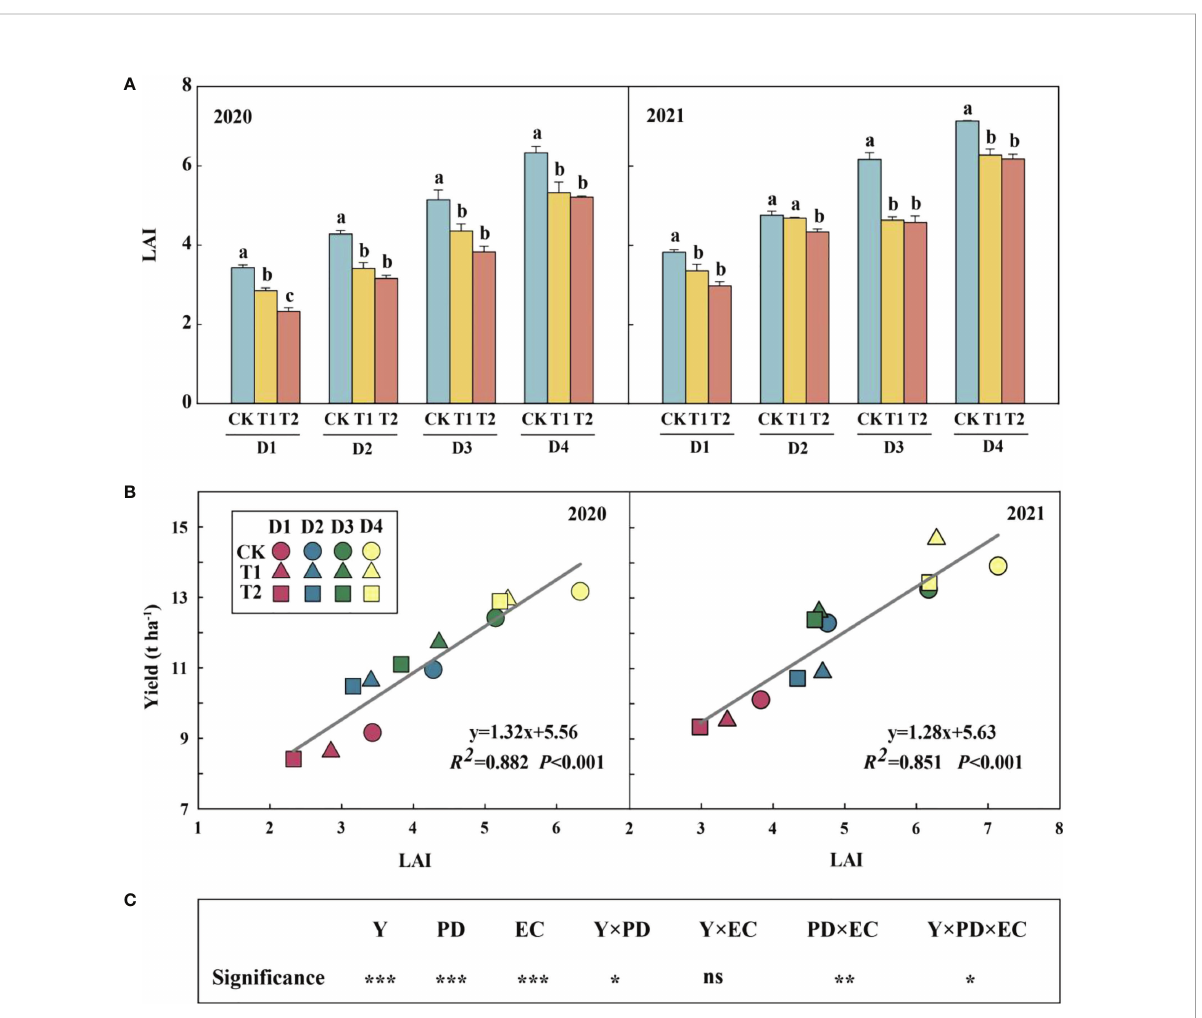
FIGURE 2 Effects of EC and PD on leaf area index (LAI) in summer maize in both years (A) . Different lowercase letters indicate signi fi cant differences between EC treatments at each plant density. Correlation of leaf area index (LAI) with yield under EC and PD in both years ( n = 12 ) (B) . Results of ANOVA on the effects of year (Y), plant density (PD), EC treatments (EC) and their interactions on LAI in 2020 – 2021 are listed (C) . R 2 indicates the coef fi cient of determination. EC, plant growth regulator; PD, plant density; D1, D2, D3, and D4 indicated plant density at 4.5, 6.0, 7.5, and 9.0 plants m − 2 , respectively; CK, T1, and T2 indicated water control, 2 mL L − 1 EC (ethephon: cycocel = 3:1), 4 mL L − 1 EC, respectively. ns means non-signi fi cant. R 2 > 0.4 and P < 0.05 indicate a signi fi cant relationship. *, ** and *** indicate signi fi cant differences at P< 0.05,< 0.05 and< 0.001 probability levels, respectively. The data used for the regression analysis are the mean values under each